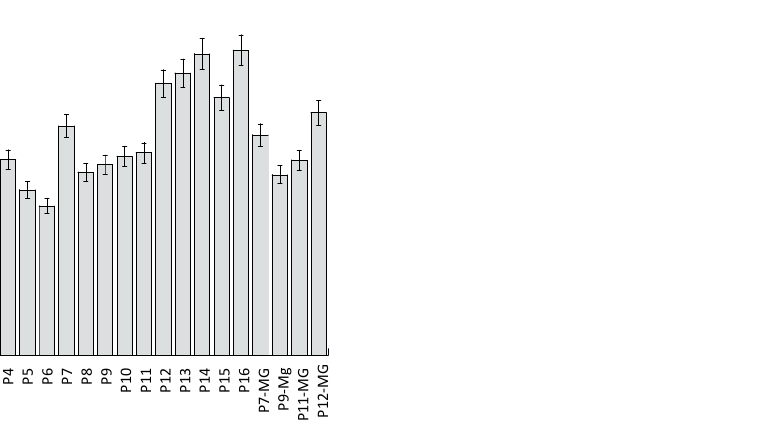
Figure 2. Transmission electron microscopy images (TEM) of P7 ( a ), P9 ( b ), P11 ( c ), P12 ( d ), P13 ( e ), and P16 ( f ). Bar corresponds to 200 nm ( a , c , d ) or 500 nm ( b , e , f ).